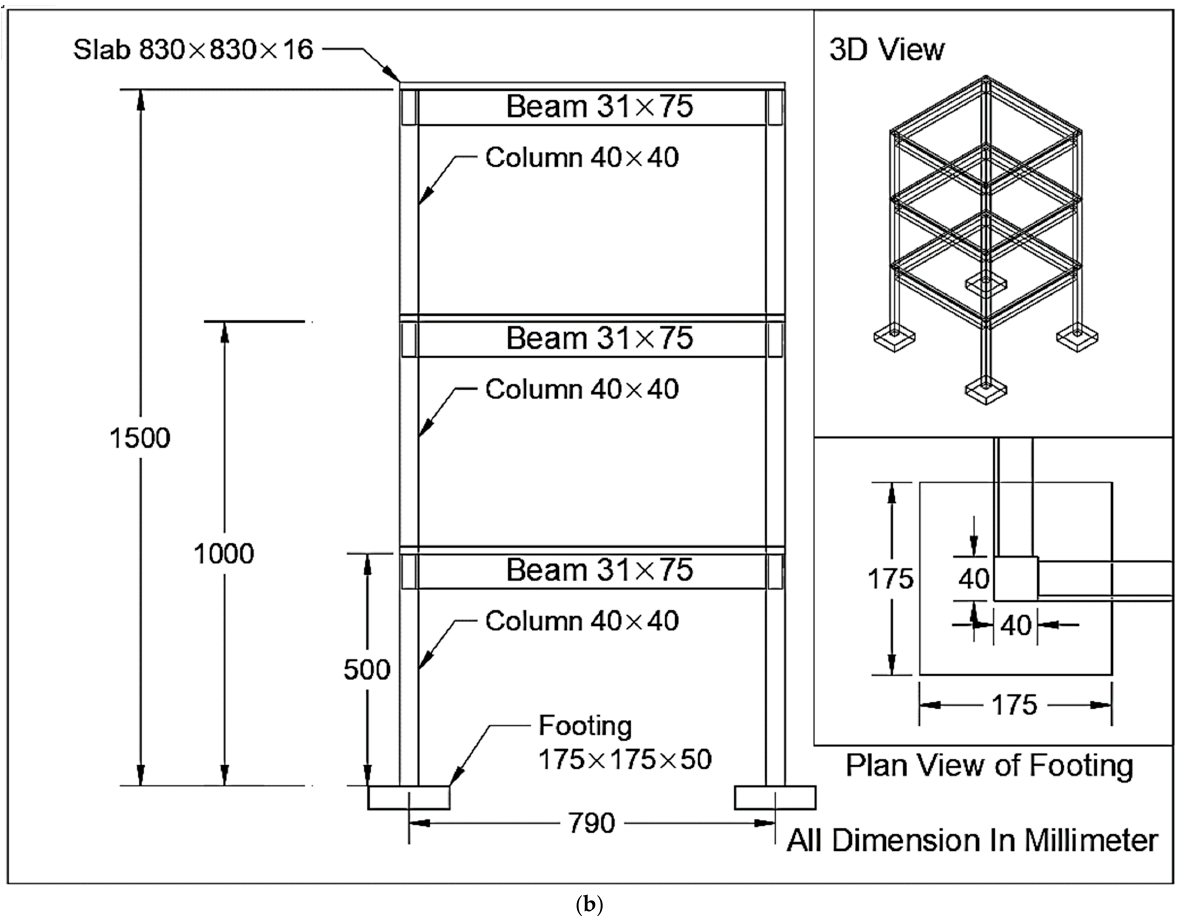
Figure 4. ( a ) Elevation view of full-scale building; ( b ) general layout of scaled RC structure.